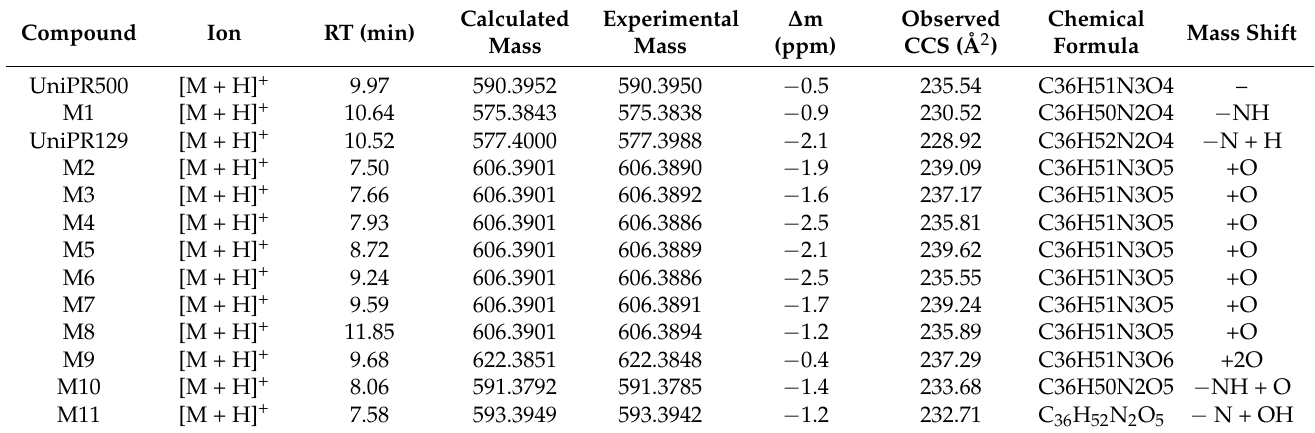
Table 3. Phase I putative metabolites of UniPR500 in mouse liver microsomes.